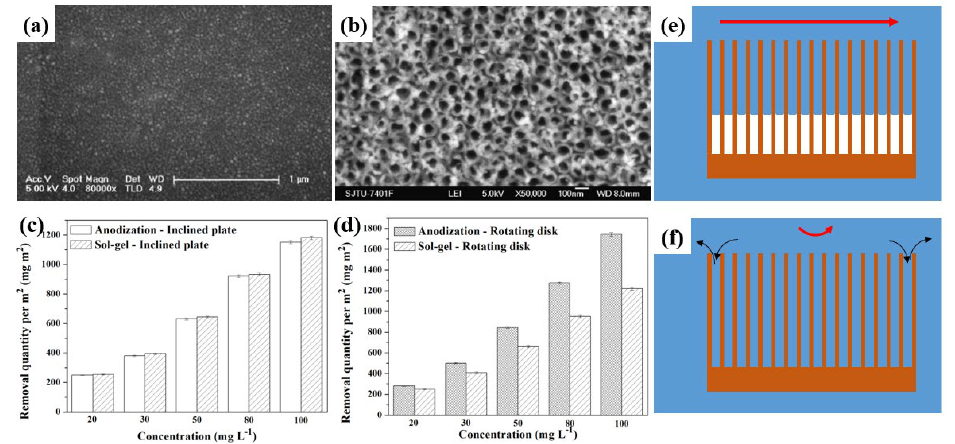
Figure 4. SEM images of ( a ) TiO 2 nanoparticle film prepared by sol − gel and ( b ) TiO 2 nanotube array film prepared by anodization, absolute quantity per m 2 of RhB removal for 1 h obtained in ( c ) inclined plate reactor and ( d ) rotating disk reactor, the schematic diagrams of water in nanotubes in ( e ) inclined plate reactor, and ( f ) rotating disk reactor. (Reprinted/adapted with permission from Ref. [63]. 2012, ELSEVIER .